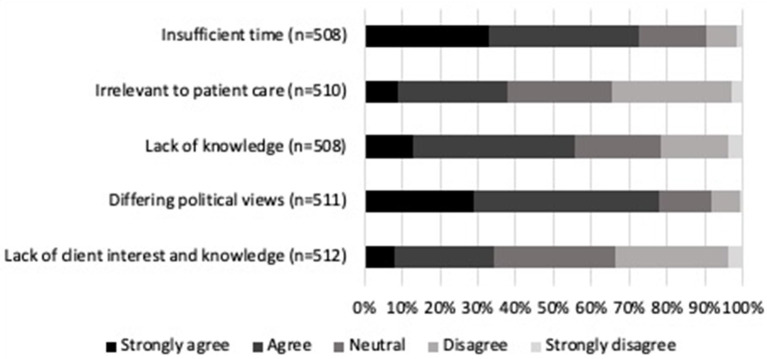
Percentage of level of agreement or disagreement from veterinarians on potential barriers preventing veterinarians from addressing climate change-related health issues with clients. Complete statements can be found in Appendix 1.